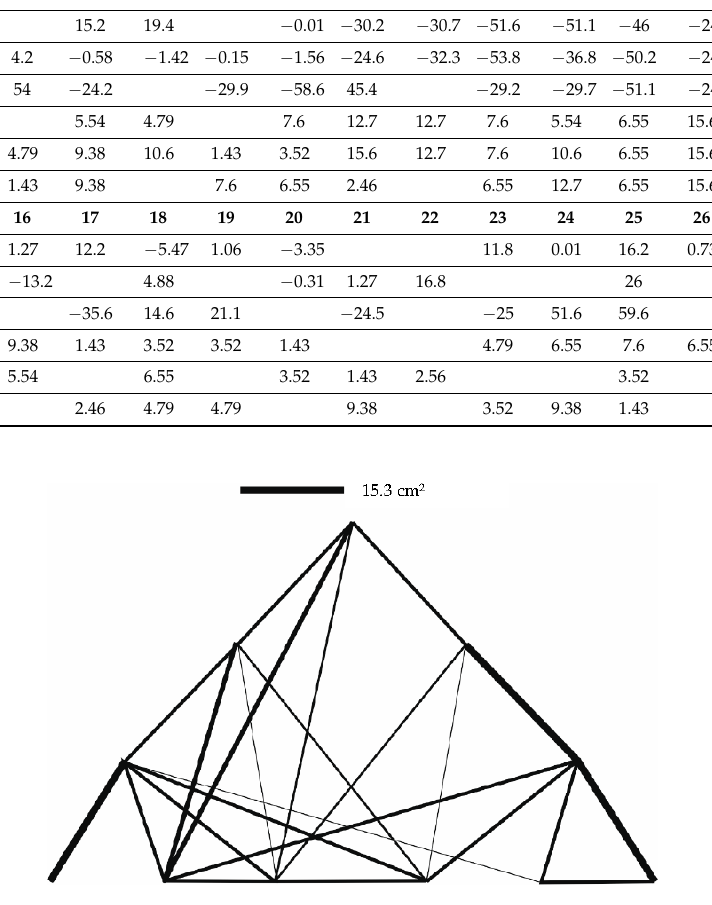
Figure 7. Truss structure after optimization—12 individuals in population (case a).